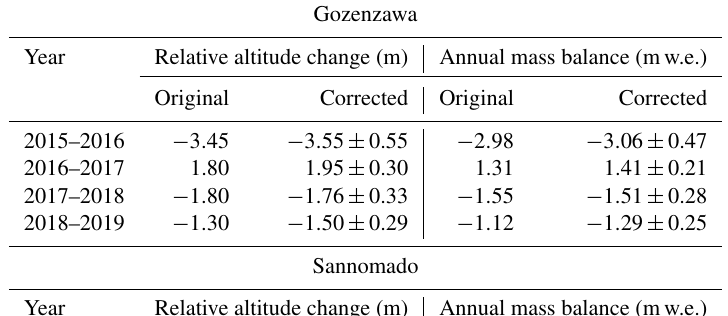
Table 3. Relative altitude change and annual mass balance of each glacier calculated from comparison of the DSMs at the end of snowmelt season. Corrected data were calculated using the mean and SD in Table 2. We subtract the mean value of the difference in the buffer zone from the value of the difference on the glaciers. The SD of buffer zone is used as the error ( ±